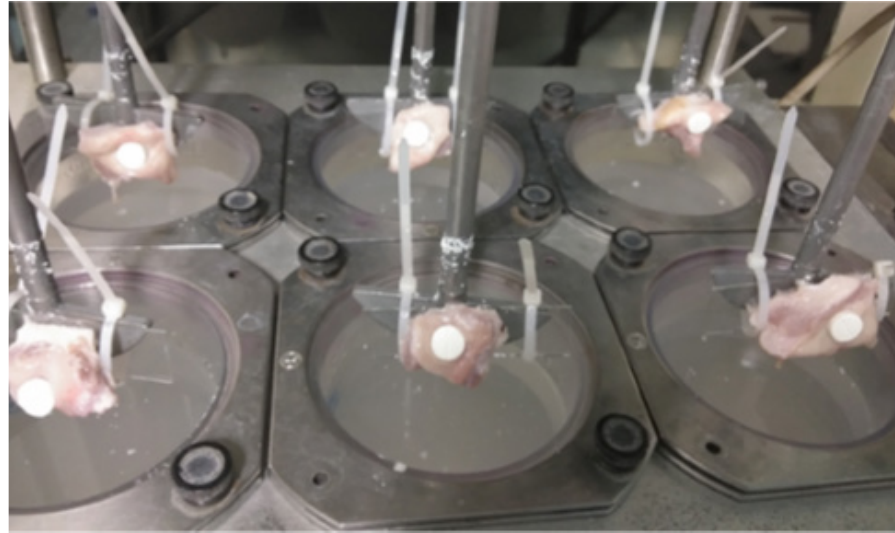
FIGURE 2 - Residence time using modified dissolution